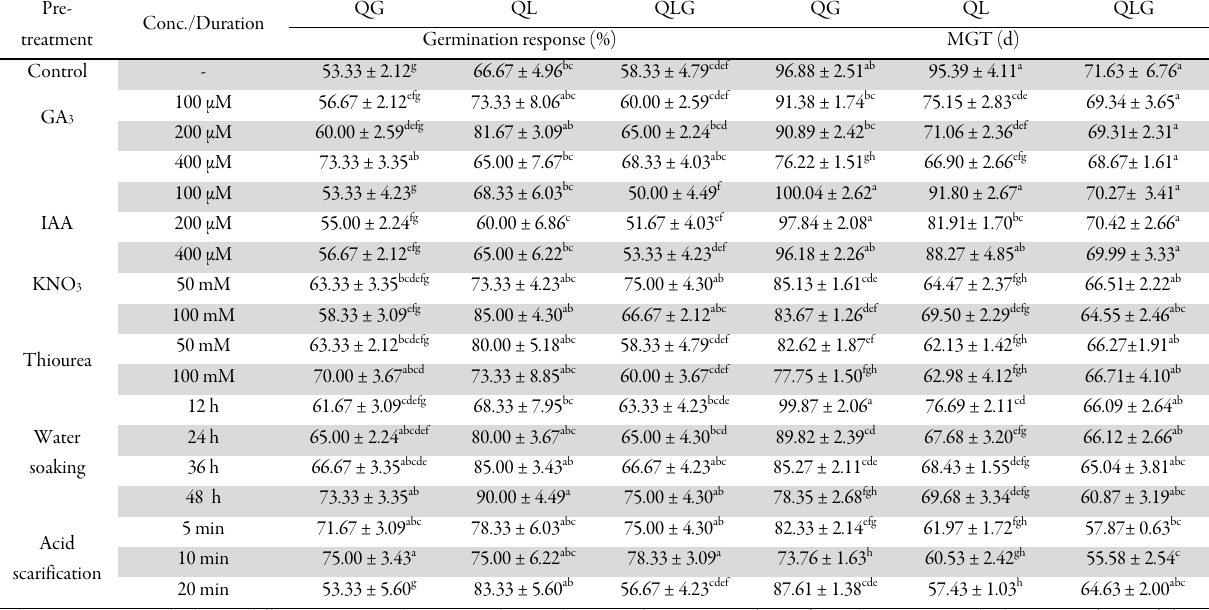
Table 4. Germination responses and MGT under various pre-sowing treatments in three oak species in Kumaun, West Himalaya Pre- treatment